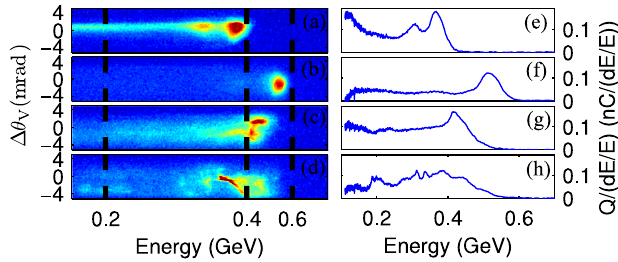
FIG. 3. (Color) Raw electron energy spectra (a)–(d) showing the fluorescence from L2, and spectra in units of charge per relative energy spread (e)–(h) for: (a),(e) P ¼ 50 mbar , t d ¼ 147 ns ; (b),(f) P ¼ 80 mbar , t d ¼ 189 ns ; (c),(g) P ¼ 110 mbar , t d ¼ ¼ 150 ns 181 ns ; (d),(h) P ¼ 200 mbar , t d